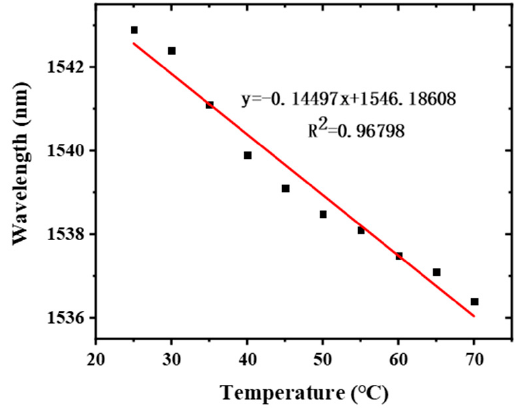
Figure 11. Temperature sensitivity of the functionalized fiber optic sensor.